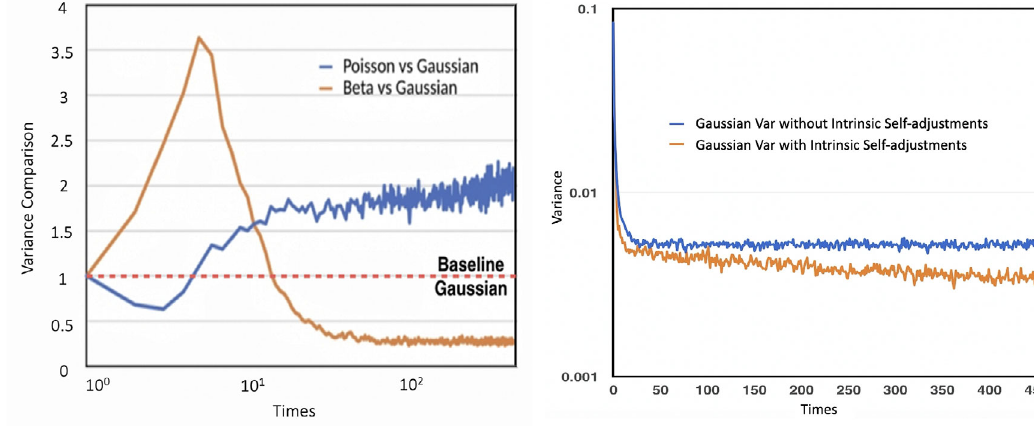
Fig. 6 Opinion dynamics with different stubbornness distributions and sparse interaction